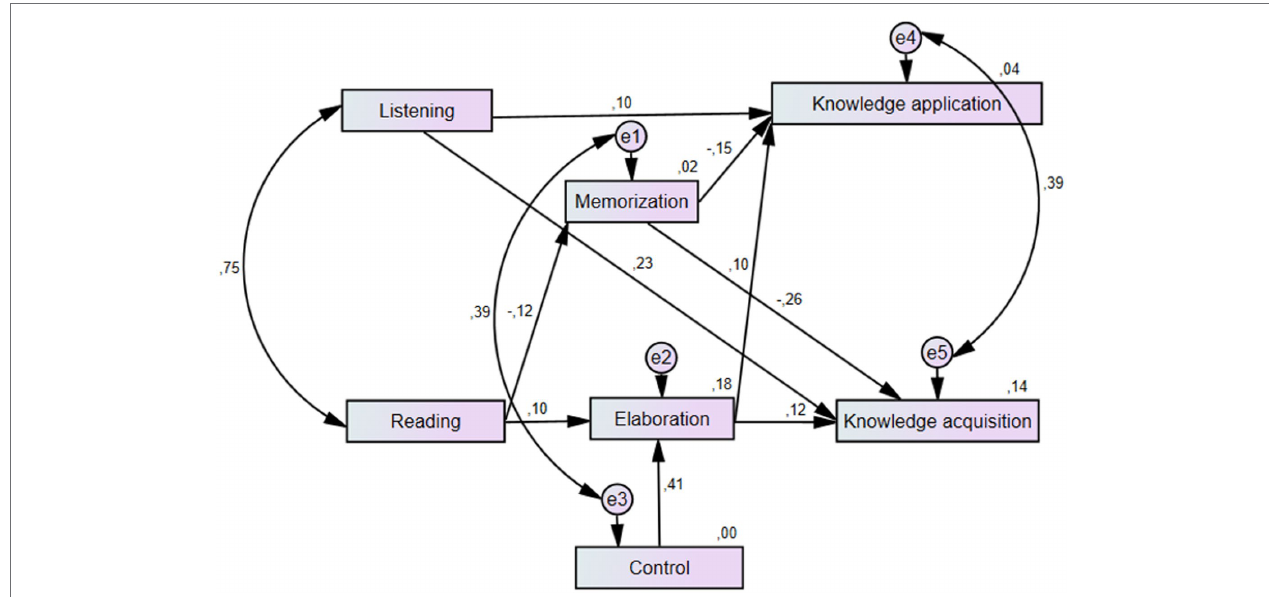
FIGURE 2 | Structural model for English as a foreign language (EFL) receptive skills, learning strategy use, and knowledge acquisition and